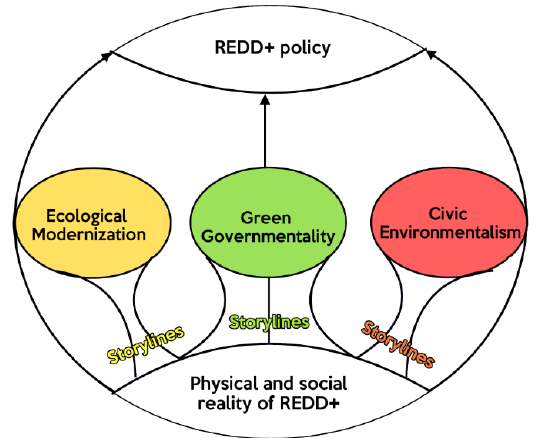
Figure 1. Schematic representation of storylines and discourses on REDD+ policy. ( Source: Authors’ own illustration). The colored yellow, green, and red circles in Figure 1 represent different discourses. The threads underneath the circles represent the different contributing storylines that actors develop to support certain discourses, based on their physical and social realities.